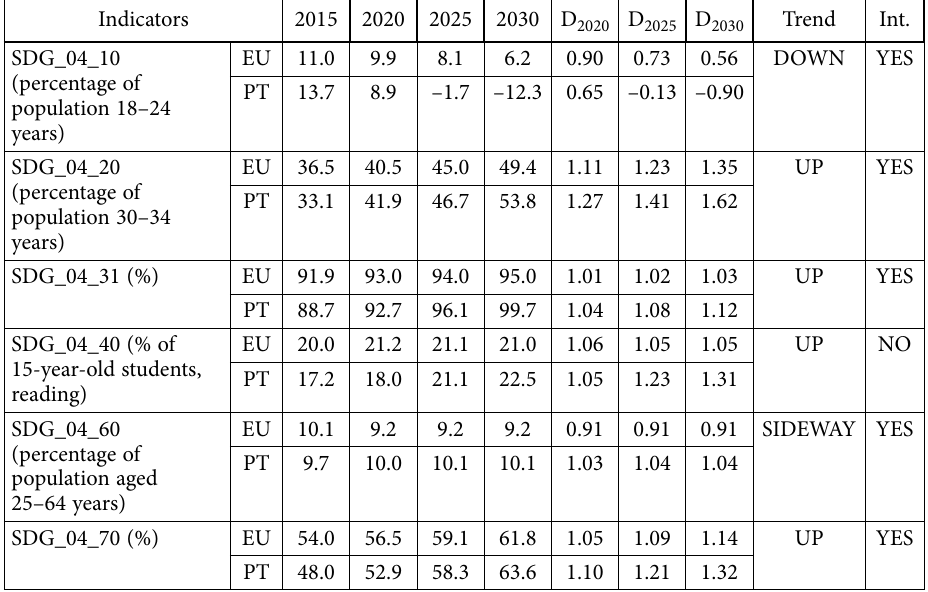
Table 5. SDG 4 – Quality education